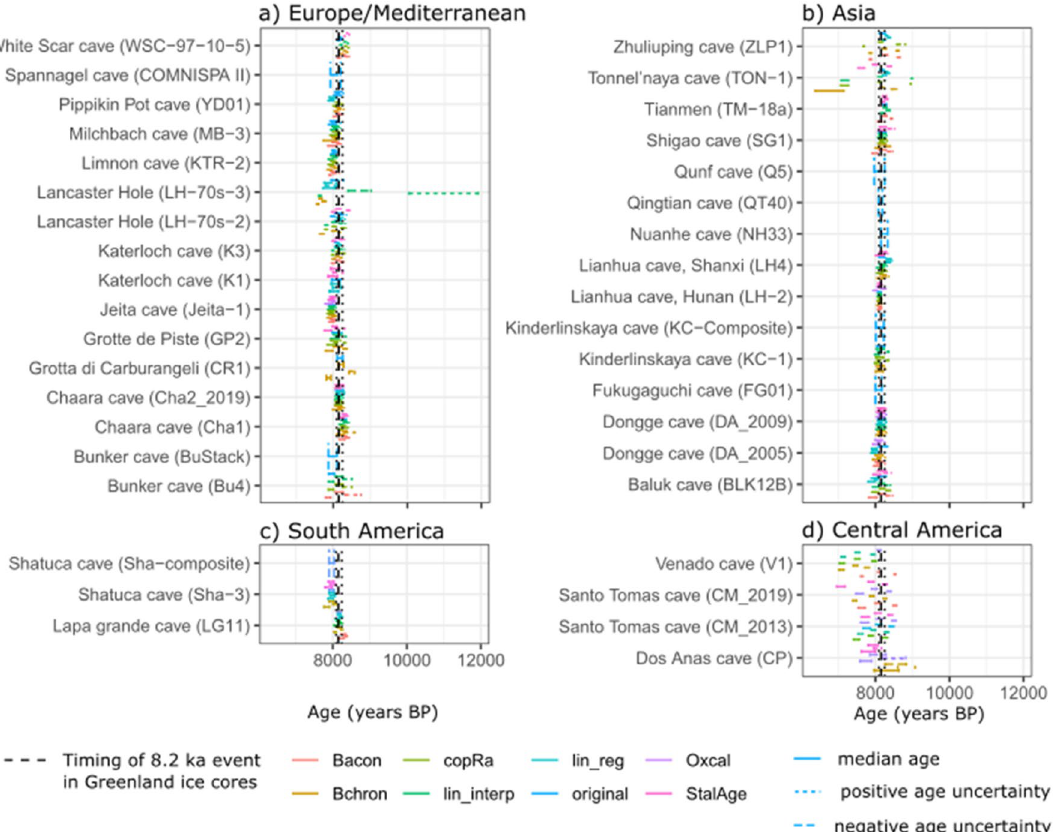
Figure 3. Start and end of the 8.2 ka event for each record and each age-depth modelling approach, constrained by breakpoint analysis. The original chronologies are shown together with the SISALv2 chronologies. Upper and lower age uncertainties associated with each age-depth model are given (dashed lines). The 8.2 ka event timing in the Greenland ice core record is shown 12 .